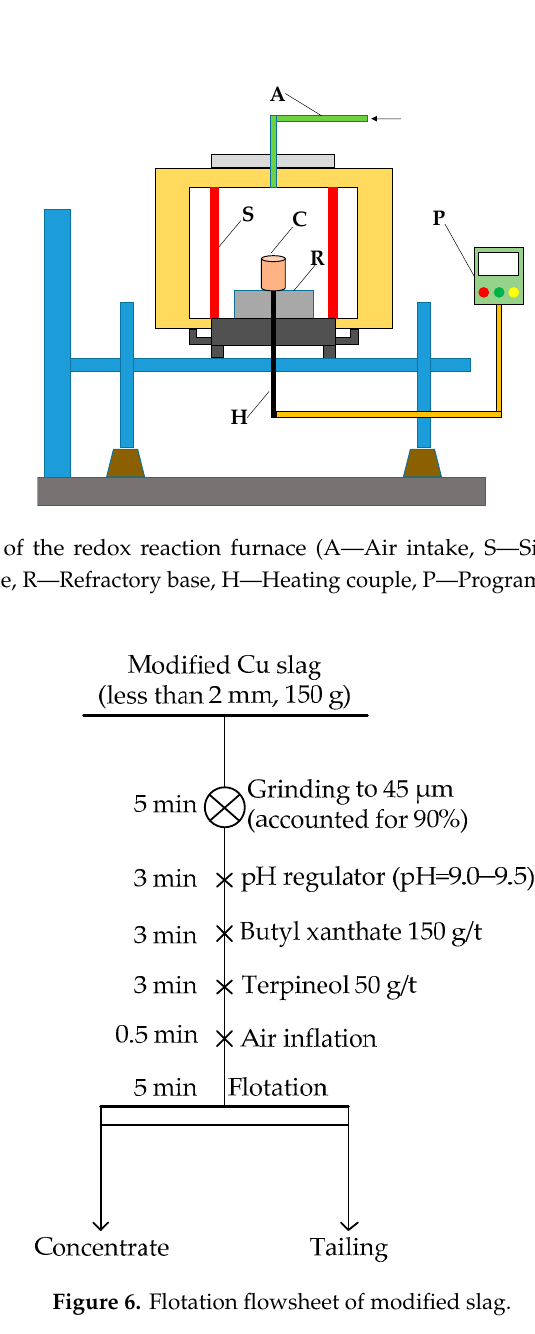
Figure 4. Melting modification test flowsheet of Cu slag.